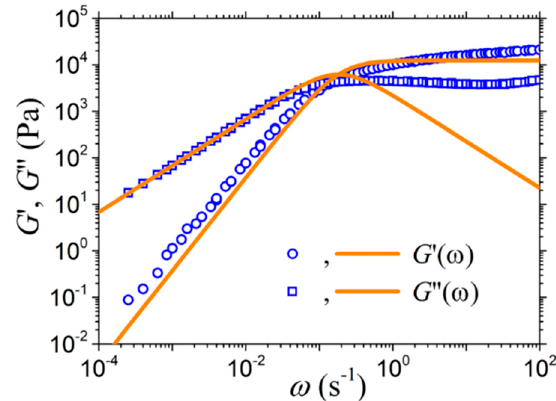
Figure 5. Comparison of the model predictions with the experimental data considered in Ref. [17] for the storage and loss moduli at 30 °C of a nearly monodisperse PS solution with Μ = 899 kDa and polymer volume fraction 36.7% (Z = 13.9) characterized by τ d = 11 s and η 0 = 68 kPa.s.